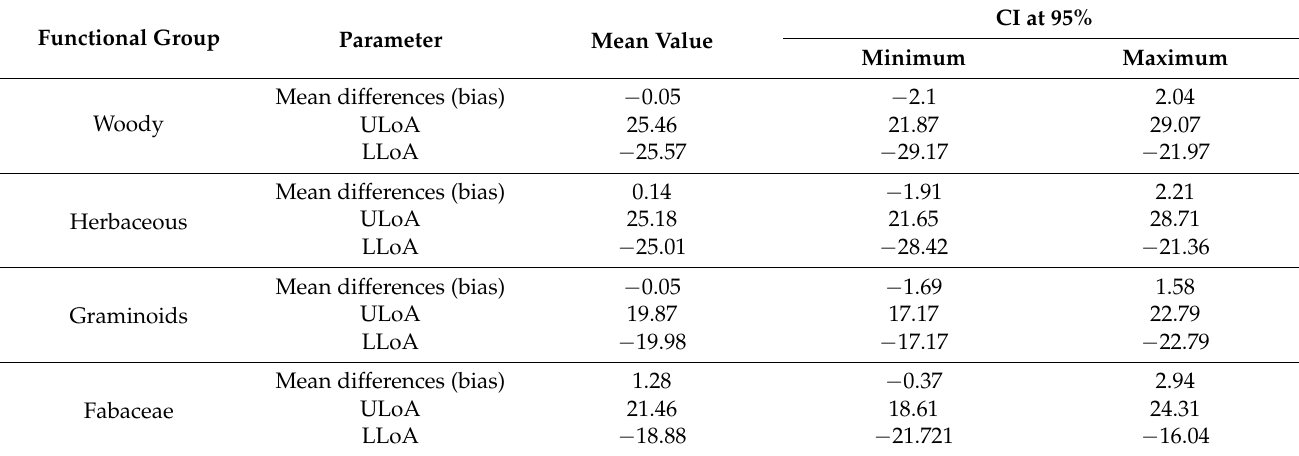
Table 4. Descriptive statistics for the Bland–Altman analysis of agreement between the fecal cuticle microhistological analysis and near infrared reflectance spectroscopy predictions for four functional groups of plants found in fecal samples of Pyrenean chamois, collected in the French and Spanish